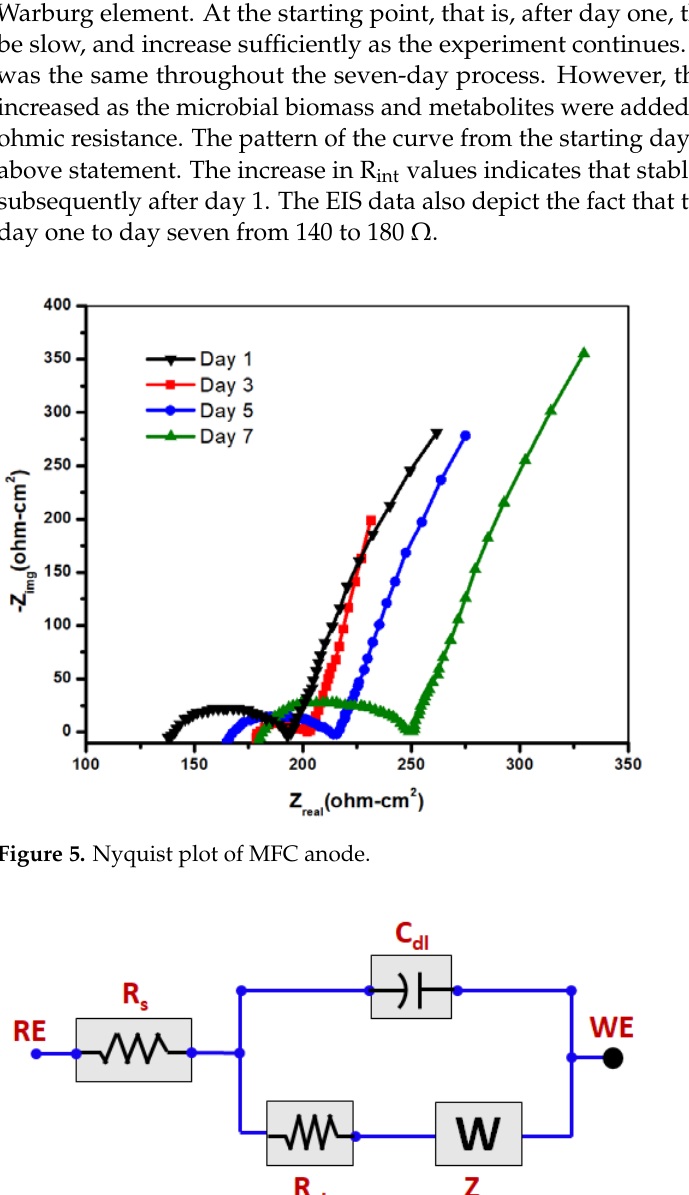
Figure 4. Variation of power density with a current density of MFC.